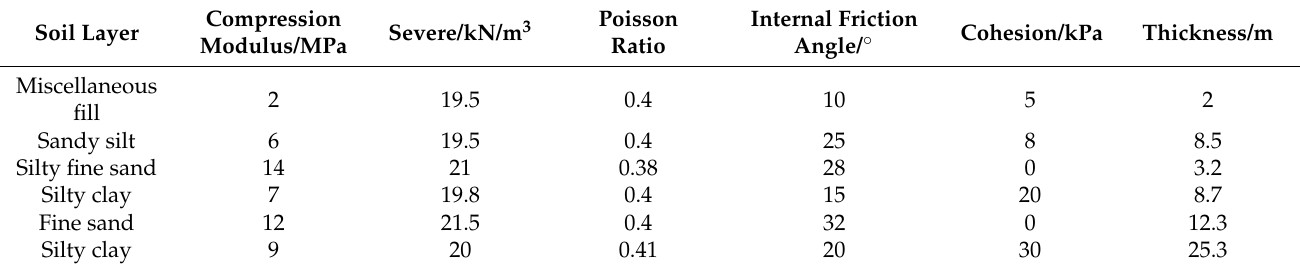
Table 2. Proposed table of geotechnical mechanical parameters.